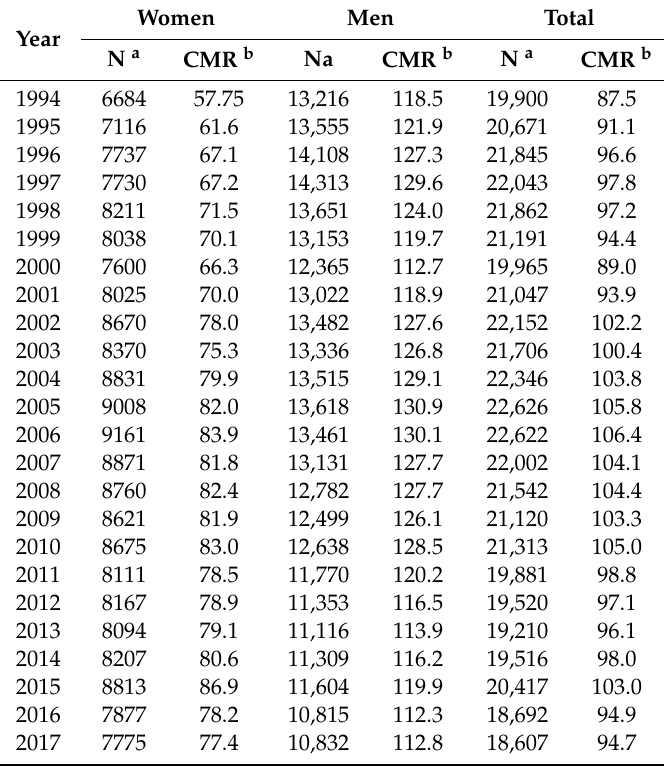
Table A3. Acute myocardial infarction crude mortality rates in Romania (1994–2017).